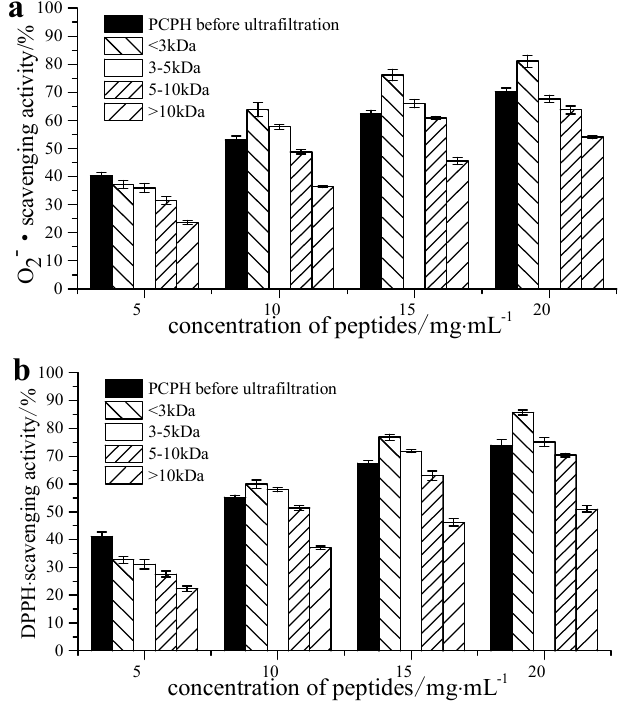
Figure 1. Free radical scavenging activity of fractions of PCPH at different concentrations: ( a ) O 2 − ∙ Figure scavenging activity; ( b ) DPPH scavenging activity.